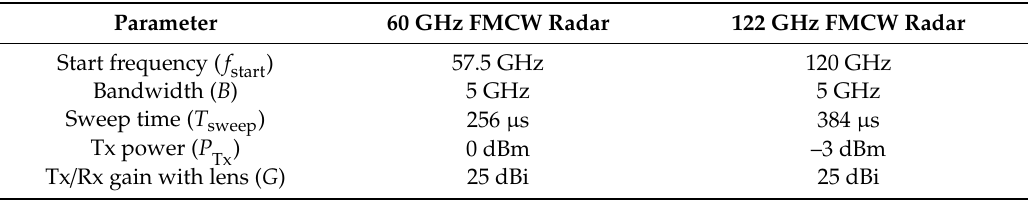
Table 1. Parameters of the 60 GHz and 122 GHz FMCW